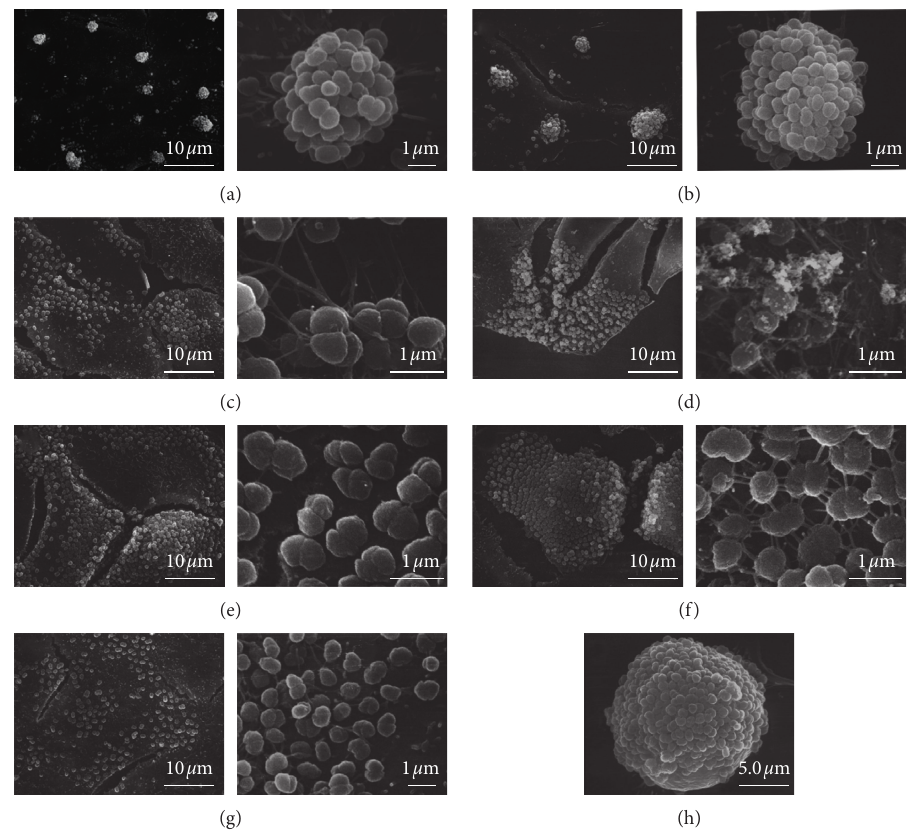
Figure 3: Scanning electron micrograph showing adherence of bacterial reisolates to host cells. Each panel depicts a representative group of bacteria ((a–h) represent MS11, G29, 4R1, SA, 7uB, 6uF, V3, and 7uB, resp.). The left panel indicates the low power magnification and the right panel indicates the higher magnification. Scale bars are mentioned at the right bottom of each image. Figure 3(h) depicts the interaction of 7uB to dust or unknown bead particles.